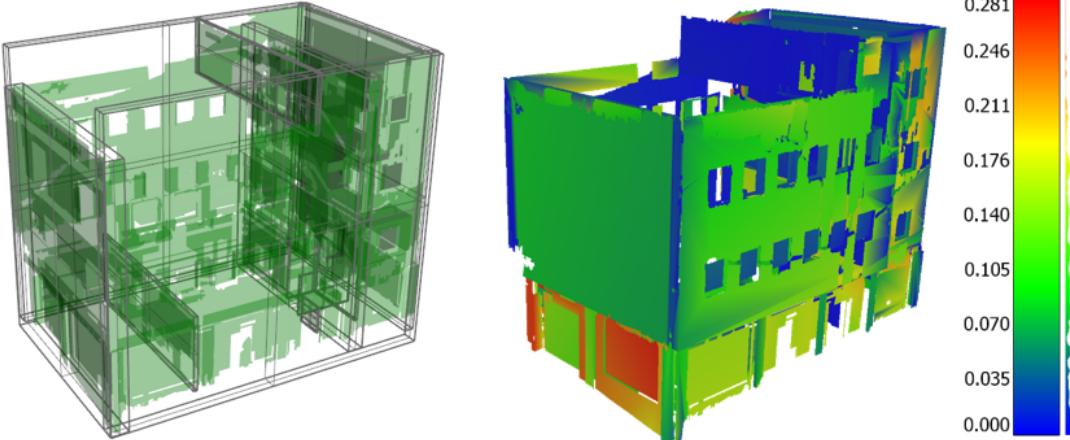
Figure 5: Overview Results wall reconstruction: The wall segments in green and the IfcStandardWallcase objects in grey (left) and the deviations between the model and the initial point cloud (right).